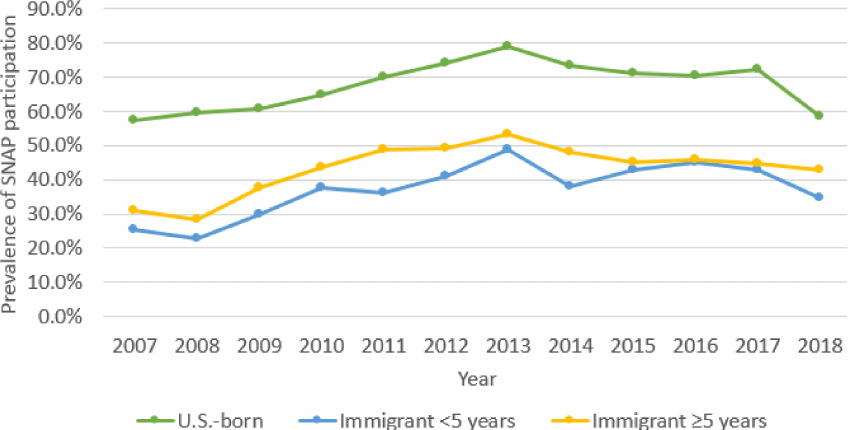
Figure 4. Trends in SNAP participation 2007–2018 by mother’s place of